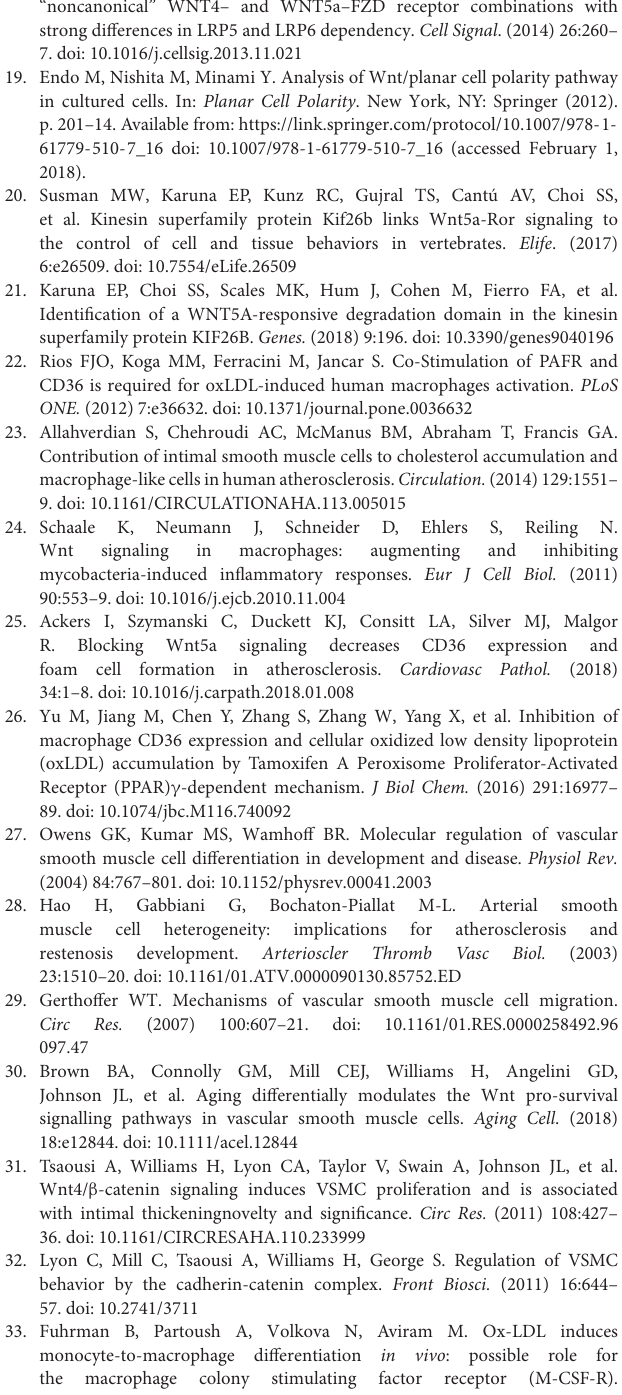
Supplementary Figure 3 | Lipid Accumulation in response to WNT proteins in THP-1. Representative confocal fluorescent images of THP-1- derived macrophages. LipidTOX TM staining was used to evaluate the accumulation of neutral lipids within differentiated macrophages. The untreated (UT) controls were held for the duration of the in vitro experiments. Cells were treated with rWNT5A (100ng/ml), rWNT3A (100ng/ml), or in combination (both 100ng/ml) as described